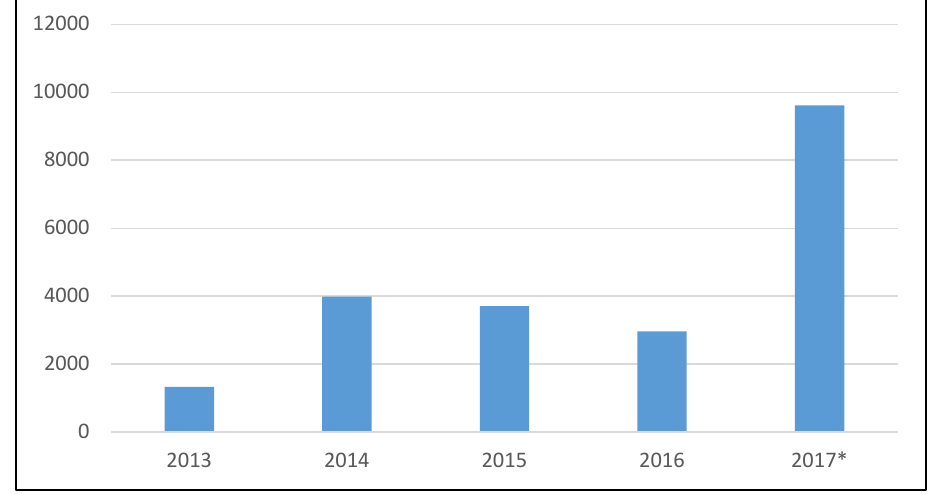
Annual Number of References Created in